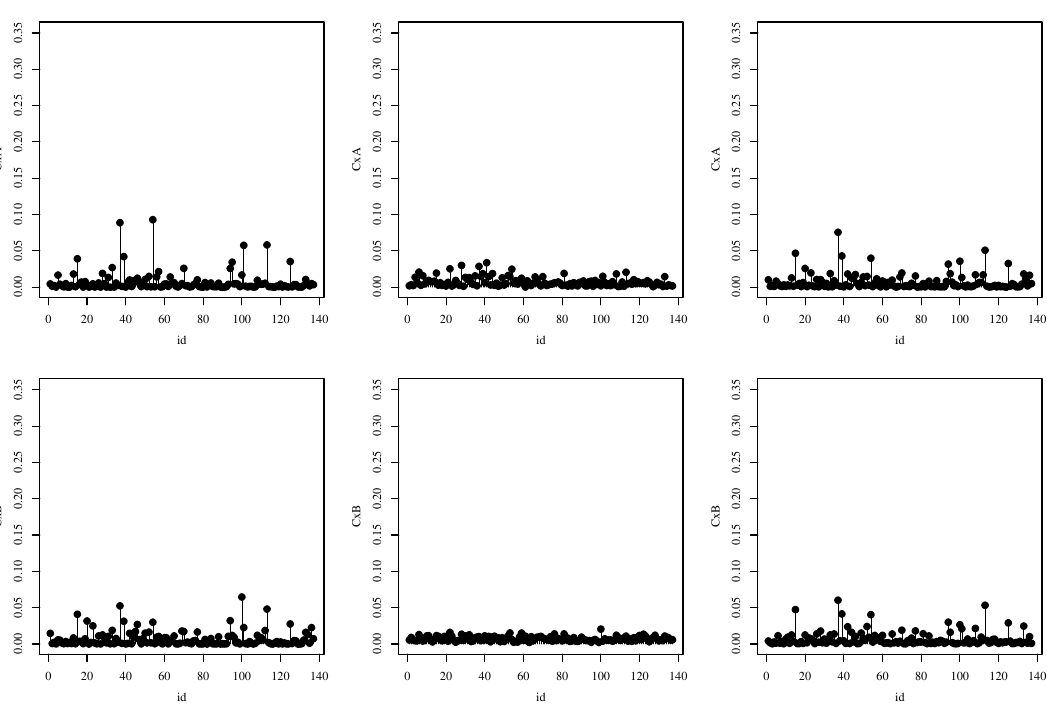
Figure A2. The index plots of C i for (cid:98) β ( upper ) and (cid:98) ν ( lower ) under the weight perturbation ( left ), response perturbation ( center ), and covariate perturbation ( right ) schemes for the RPGJSB2 q model with q = 0.25 (link loglog and G the cdf from the normal model) of the COVID-19 data set.